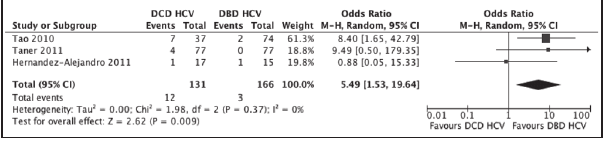
Figure 2) Forest plot of recipient survival. DBD Donation after brain death; DCD Donation after cardiac death; HCV Hepatitis C